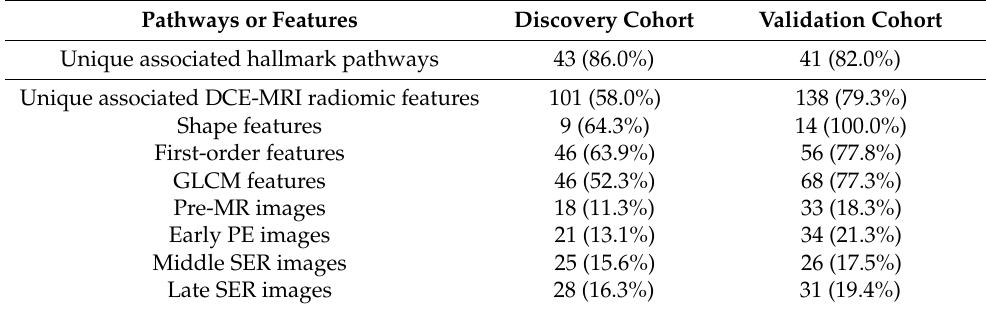
Table 2. Percentages of hallmark pathways or imaging features with radiomic–transcriptomic as- sociations. The proportion of pathways with significant imaging correlation with all 50 hallmark pathways, and the proportions of DCE-MRI features with significant transcriptomic association with all imaging features of that type were calculated and displayed for both